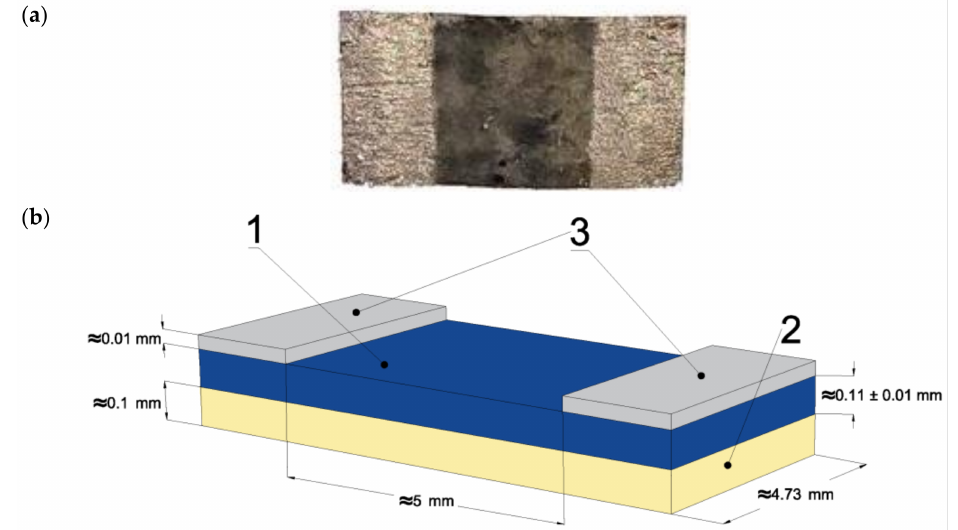
Figure 2. Photo ( a ) and view ( b ) of the nanocomposite sample: 1—MX nanocomposite layer, 2— dielectric substrate, 3—silver paste